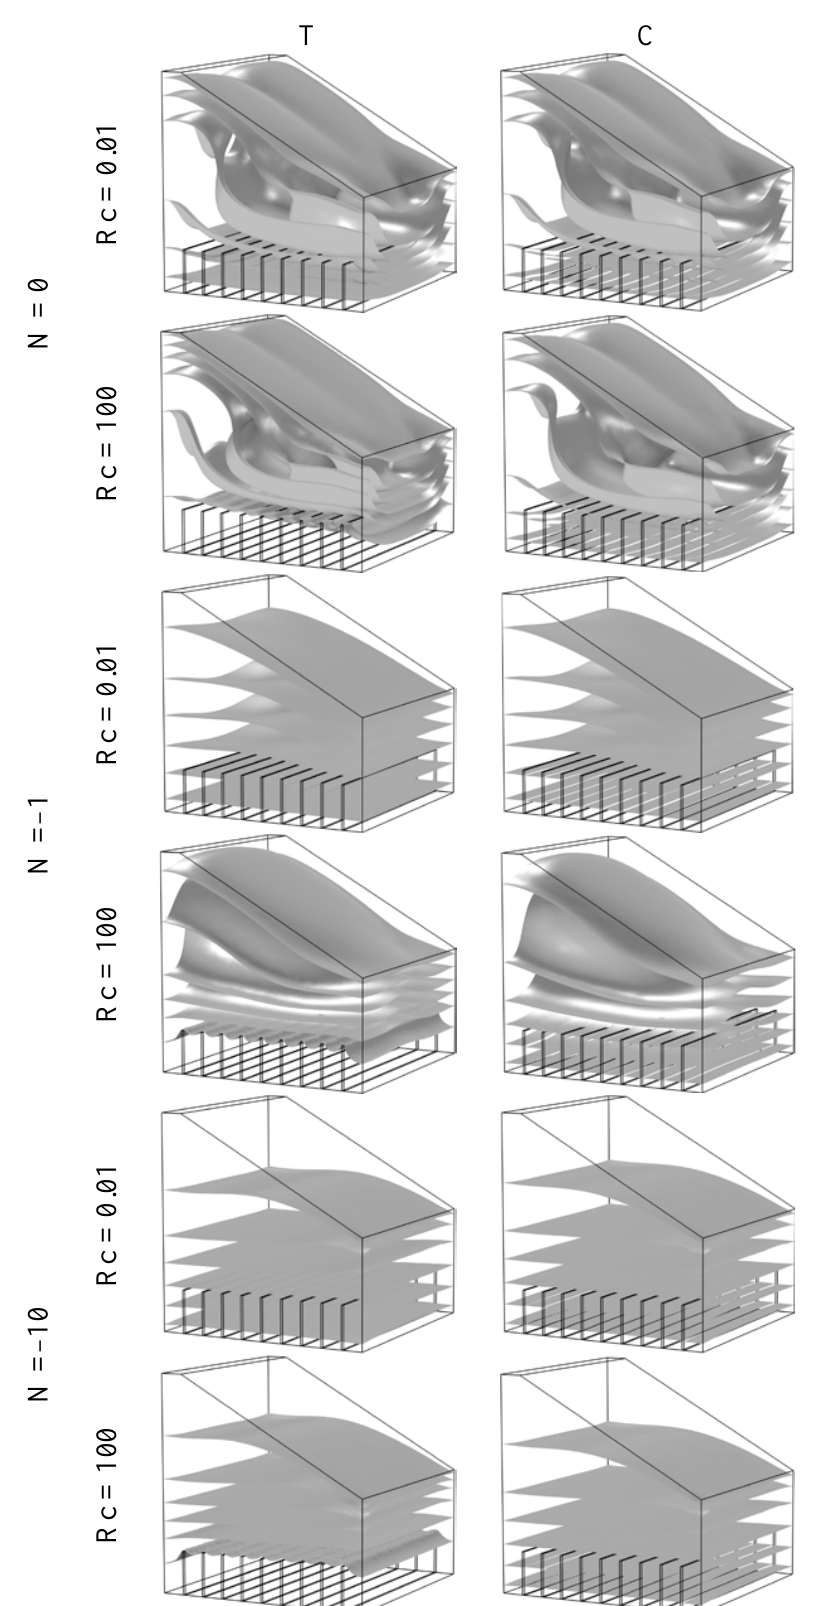
Figure 7. Effect of the buoyancy and conductivity ratios on the 3D temperature and concentration fields for Ra = 10 5 .